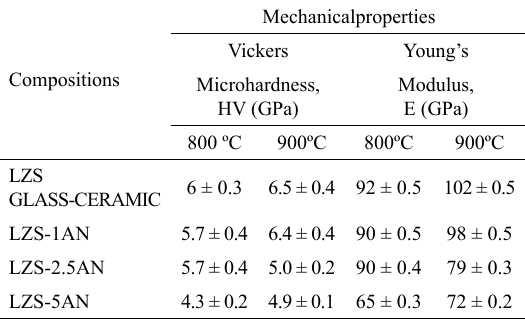
Table 4. Mechanical properties of samples fast fired at 800 and 900 ºC for 30